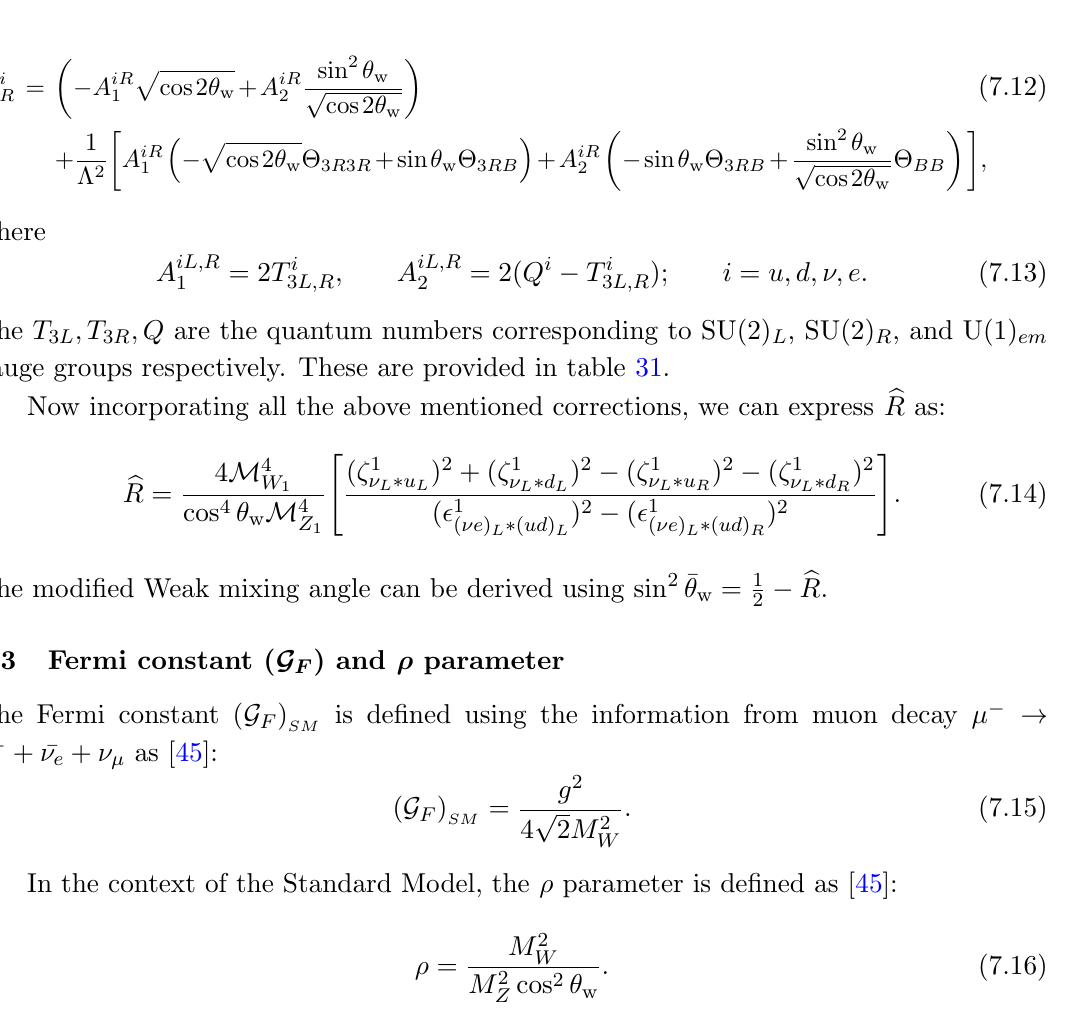
Table 31. MLRSM: T 3 L , T 3 R , Q quantum number for